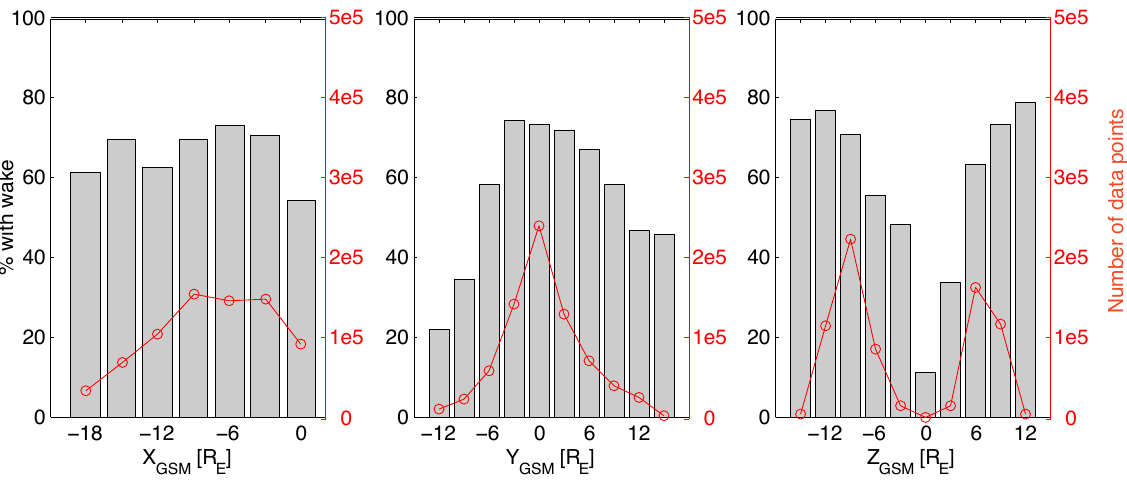
Fig. 4. Detection probability as a function of distance. Percentage of all events where cold ions have been detected as a function of X GSE / GSM , Y GSM , and Z GSM . The red points show the total number of data points in the respective region. (The total data set consists of 765000 points.)